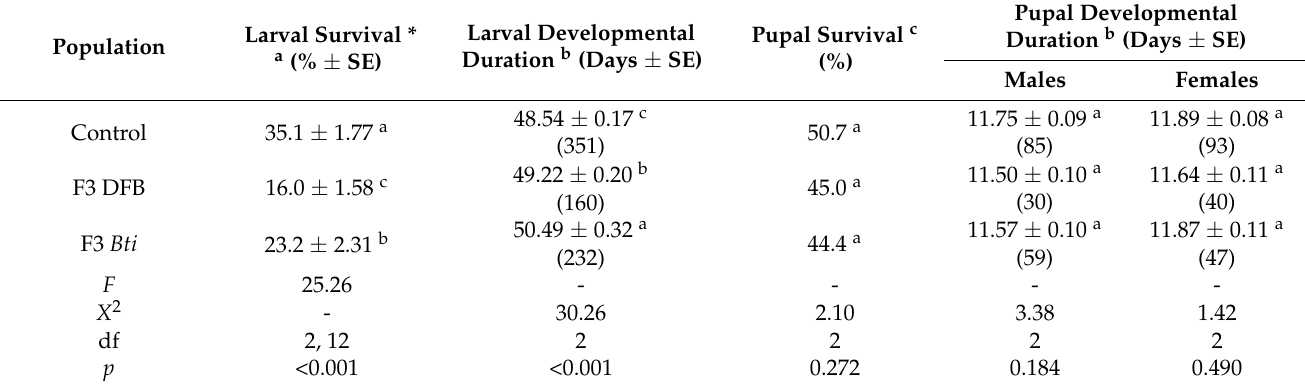
Table 3. Fitness parameters of overwintering Culex pipiens f. molestus immature stages originated from populations that were either selected against diflubenzuron (DFB) and Bti for three successive generations or not (control). Numbers in parentheses indicate the individuals that were considered in each case. In each column, different letters indicate significant differences ( p < 0.05).